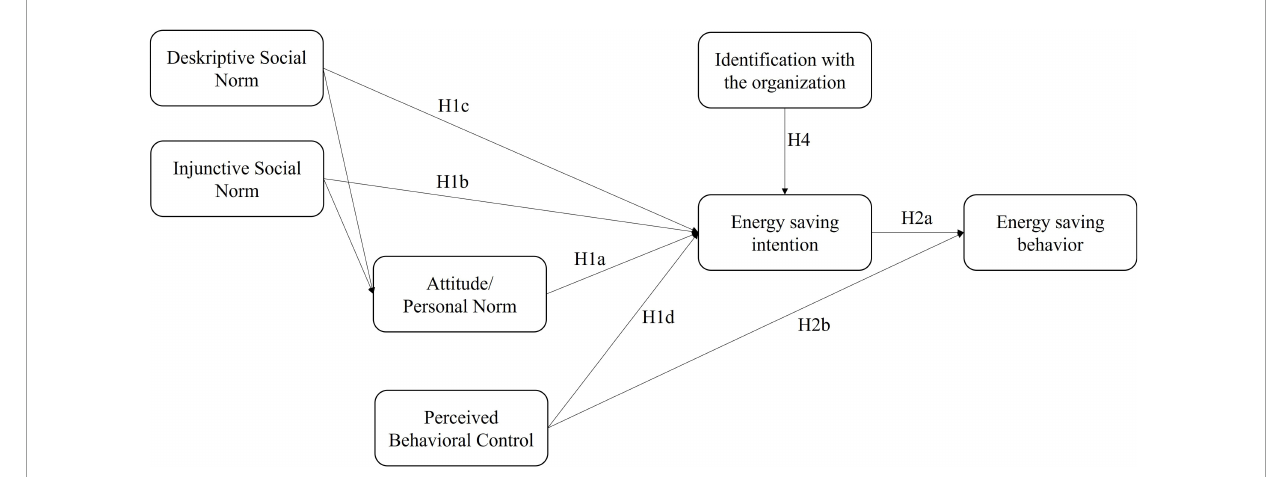
FIGURE1 Research model and hypotheses. The mediation hypotheses H3a and H3b are not displayed in this